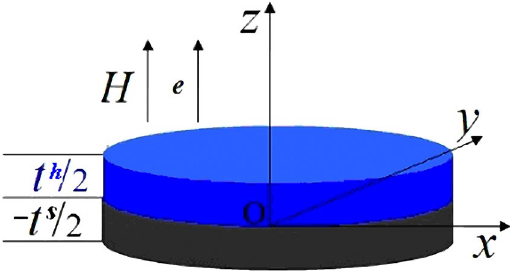
Figure 1. The basic scheme for a hard/soft multilayer calculated in this paper. Due to the symmetry, only a simplification of the symmetrical multilayer from − t s /2 to t h /2 is illustrated in the